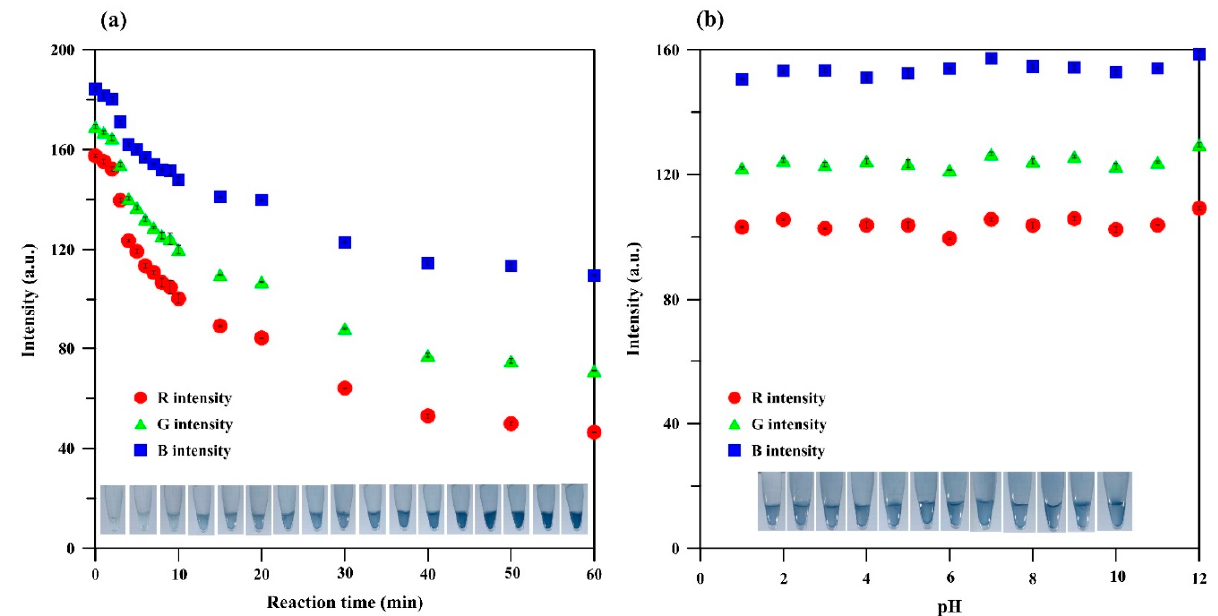
Figure 4. Influence of the ( a ) reaction time and ( b )